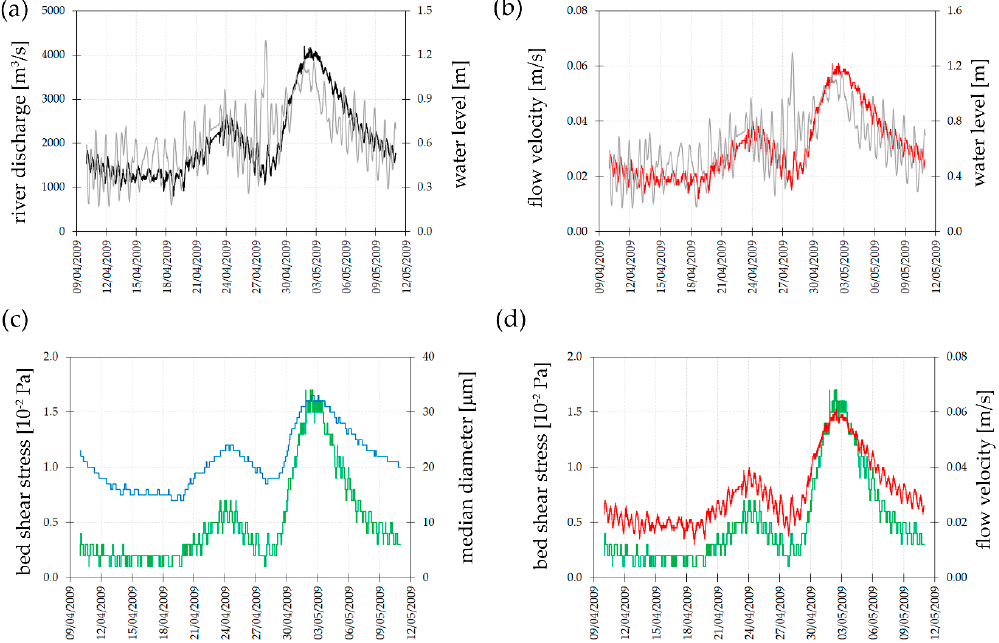
Figure 6. Simulated parameters at the E16 core location: (a) river discharge (black line) vs. water level (grey line); (b) averaged flow velocity (red line) vs. water level (grey line); (c) bed shear stress (green line) vs. active median diameter d 50 (blue line); (d) bed shear stress (green line) vs. averaged flow velocity (red line).